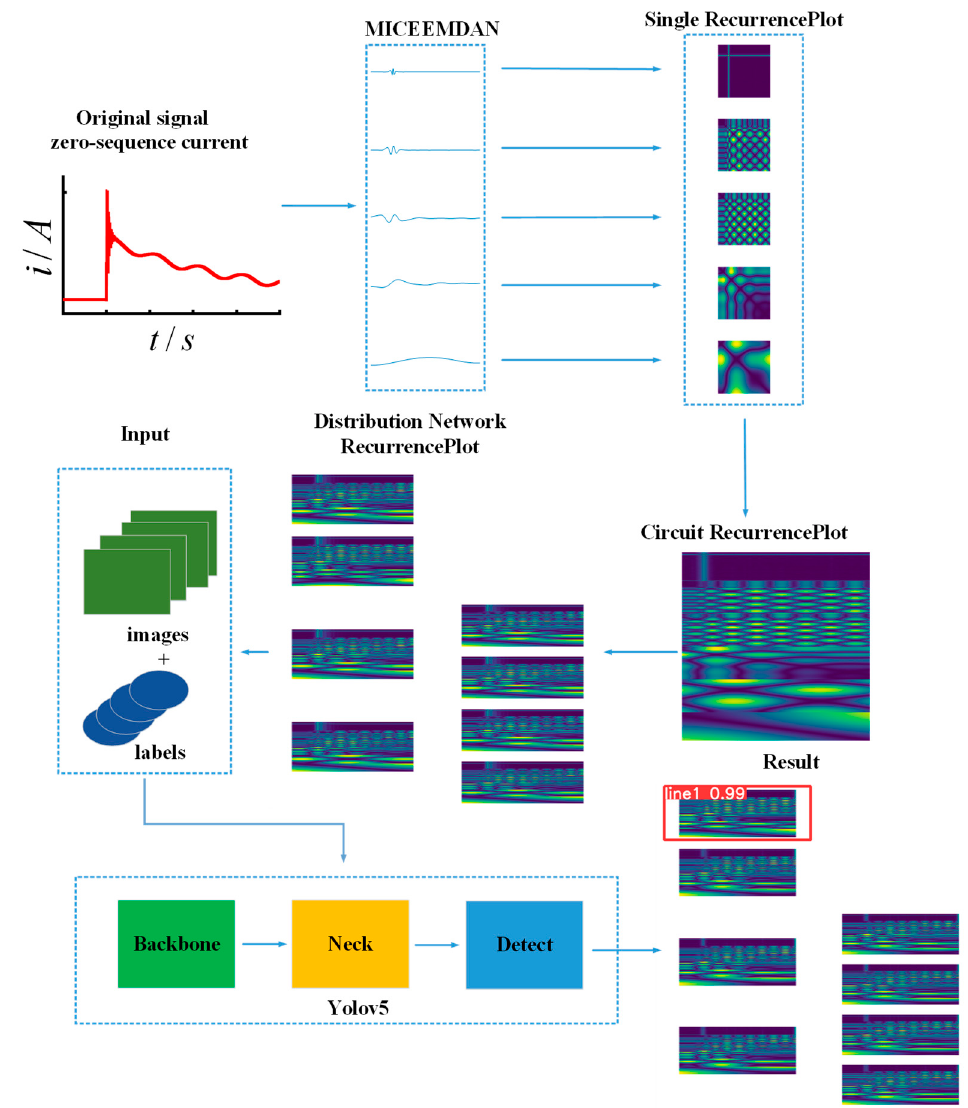
Figure 11. Fault-line selection process.